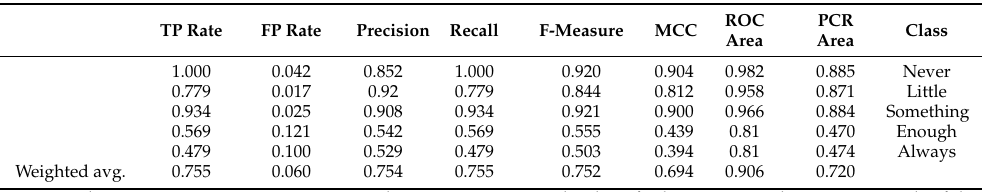
Table 15. Detailed accuracy by class, with a training dataset corresponding to 506